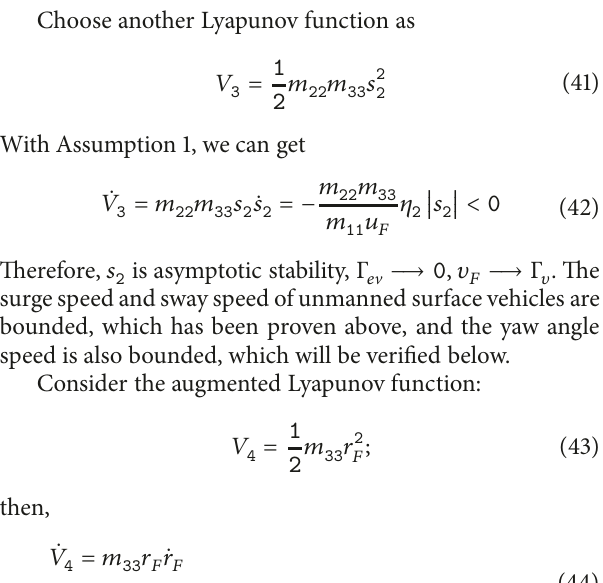
Figure 2: The USV motion curve of straight line